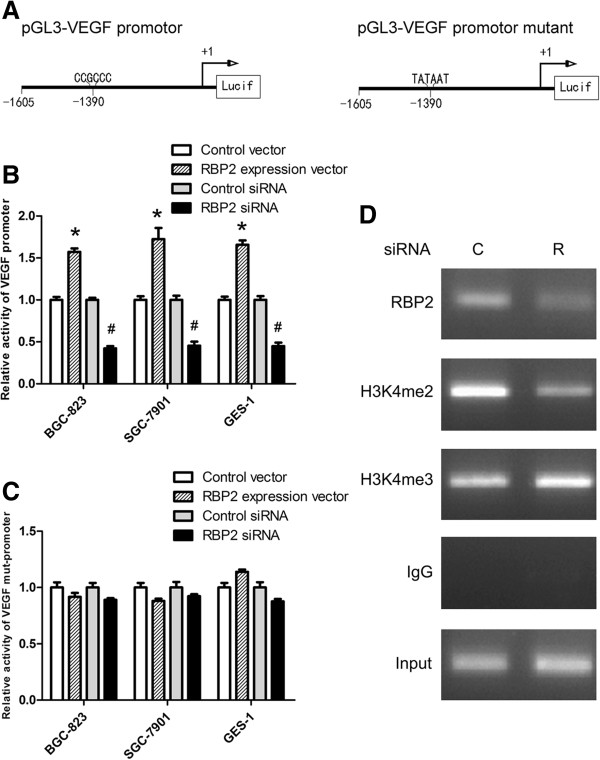
Transactivation of VEGF promoter induced by RBP2. (A) Schematic structure of pGL3-VEGF promoter and pGL3-VEGF promoter mutant. (B) After transfection of RBP2 expression vector for 48 h, luciferase activity of VEGF promoter reporters as compared with the control vector and RBP2 siRNA cotransfection for 72 h as compared with control siRNA. *P < 0.05 vs control vector. #P < 0.05 vs control siRNA. (C) The luciferase activity of VEGF promoter mutant reporters with RBP2 expression vector and RBP2 siRNA cotransfection. (D) RBP2 occupancy and trimethylation status of H3K4 at the promoter of the VEGF gene in BGC-823 cells. C and R: Control siRNA and RBP2 siRNA, respectively. Data are mean ± SEM of 3 independent experiments.